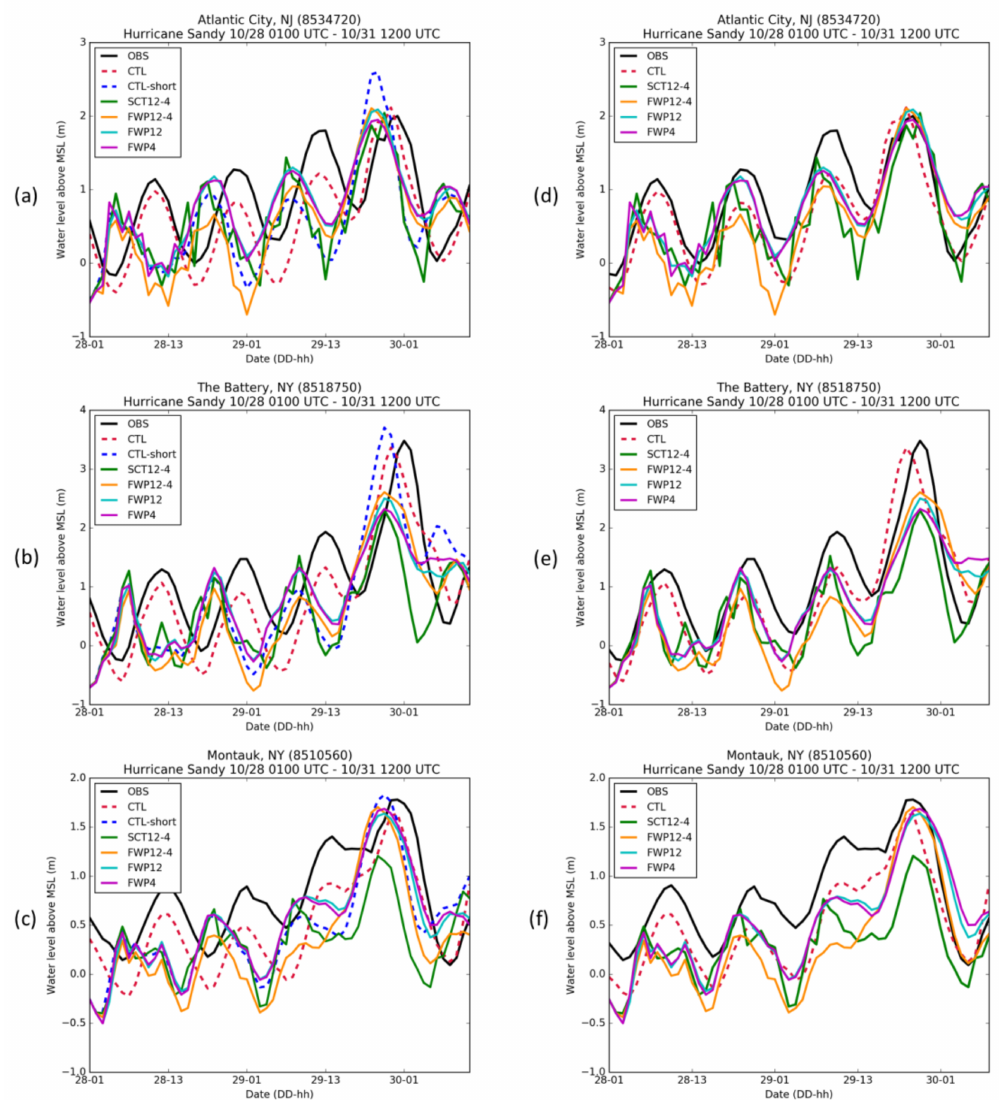
Figure 12. Times series of all simulations including a short CTL simulation for ( a ) Atlantic City NJ station; ( b ) The Battery NY station; and ( c ) Montauk NY station. The WRF-ADCIRC simulation estimates have been shifted by 3 h ahead of time to correspond with the peak of the observed water level and are shown for ( d ) Atlantic City NJ station; ( e ) The Battery NY station; and ( f ) Montauk NY